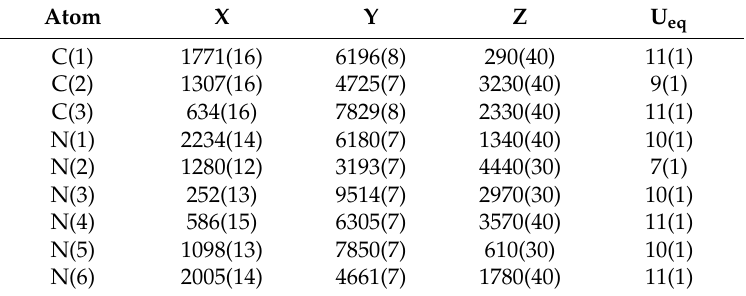
Table A2. Atomic coordinates ( × 10 4 ) and equivalent isotropic displacement parameters (A 2 × 10 3 ) for carbon and nitrogen atoms melamine at 36.21(5) GPa (2015_10). U eq is defined as one third of the trace of the orthogonalized Uij tensor.